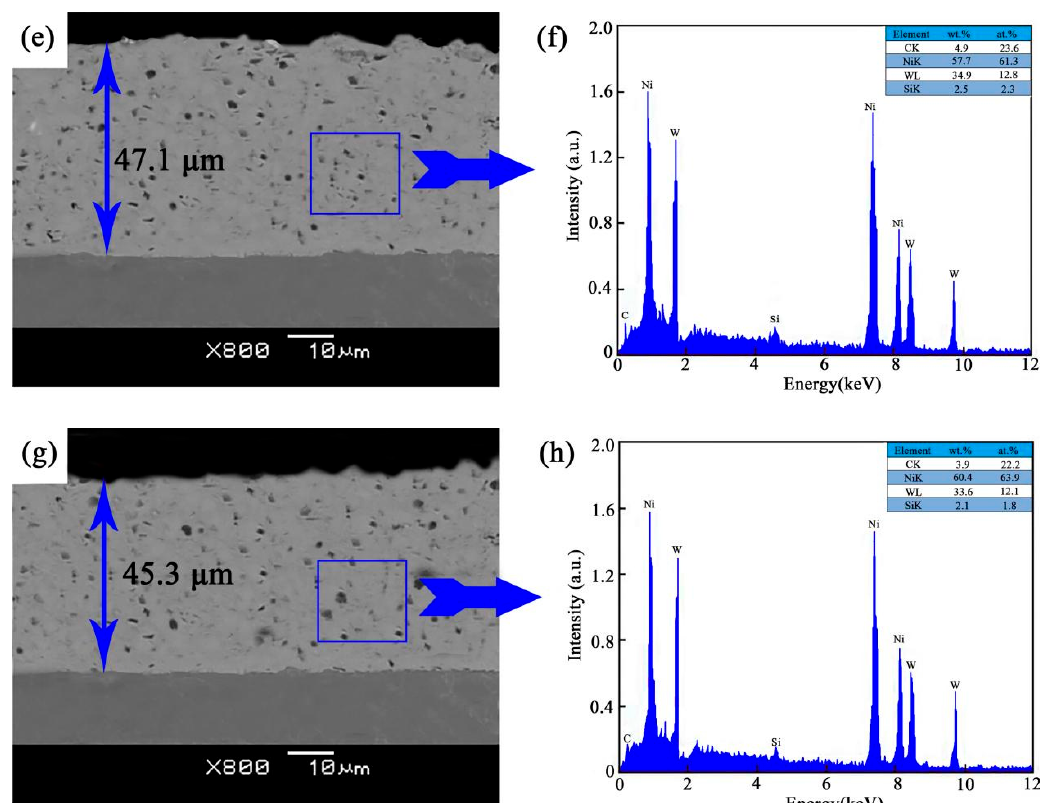
Figure 2. Cross-section SEM images of Ni/W-SiC nanocomposites: ( a ) S1, ( c ) S2, ( e ) S3, and ( g ) S4 nanocomposites, and SiC contents in Ni/W-SiC nanocomposites: ( b ) S1, ( d ) S2, ( f ) S3, and ( h ) S4 nanocomposites.